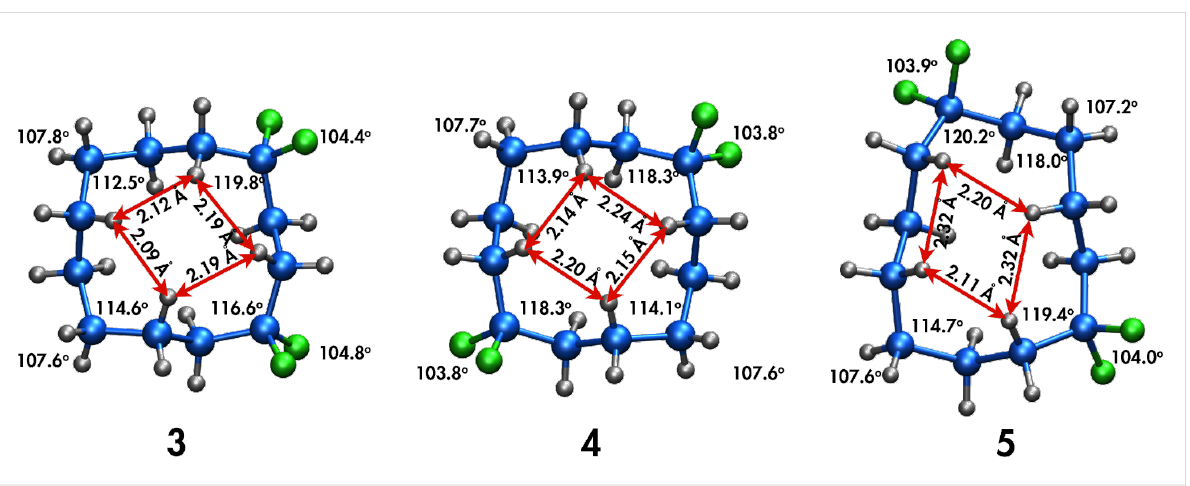
Figure 1: The CF 2 group in 1c accelerates RCM reactions relative to CHF ( 1d ) and CH 2 ( 1e ) and with a similar rate to classical or Thorpe–Ingold substituents such as the ketal 1a and dicarboxylate ester 1b [8].